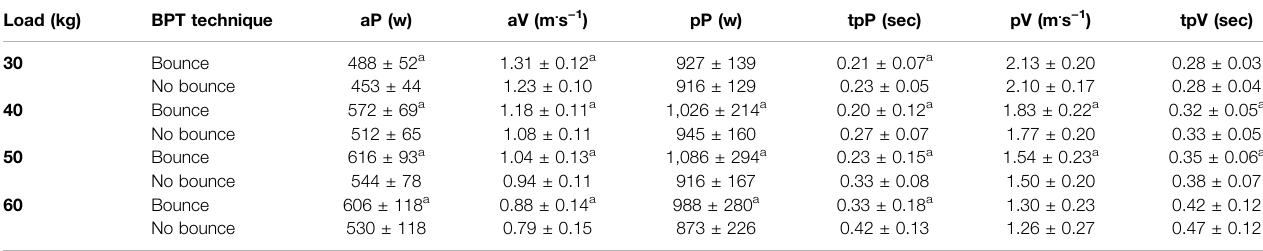
TABLE 1 | Power output, velocity, and time in BPT with and without bounce.